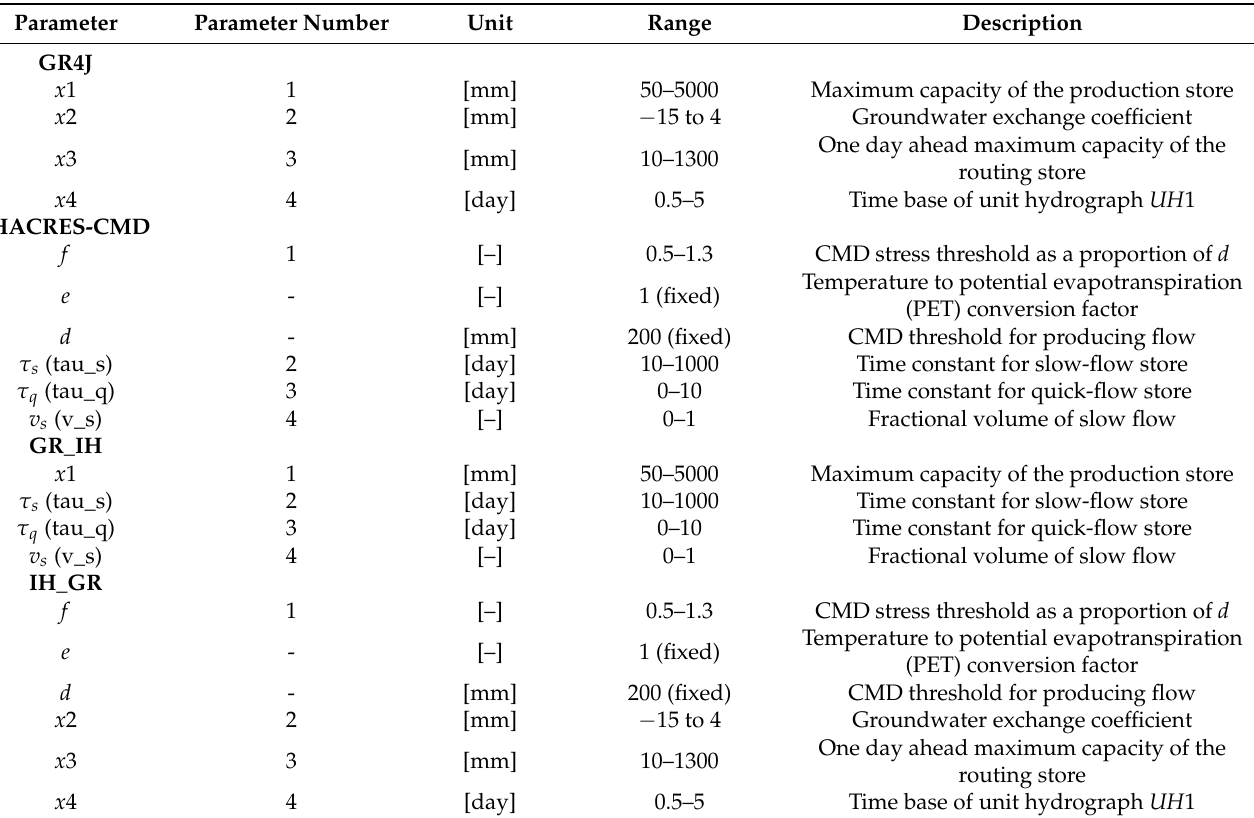
Table 2. Description of the parameters of four rainfall–runoff